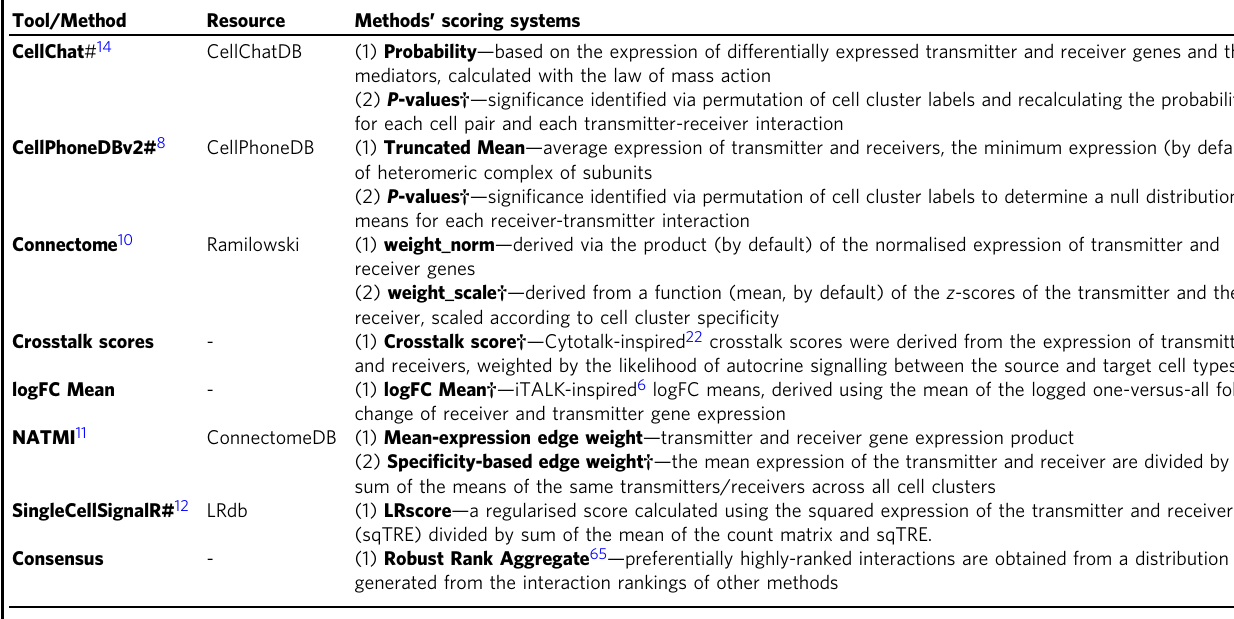
Table 1 Tools included in the